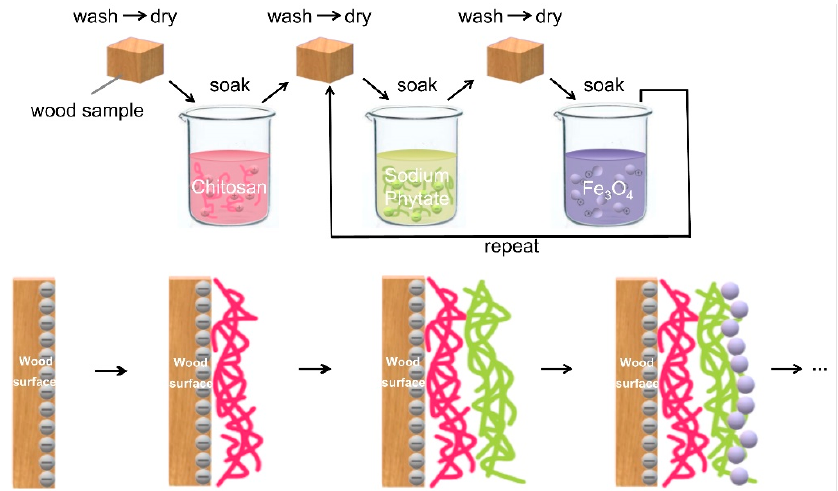
Figure 1. Scheme of fabricating magnetic coating on wood surface by layer-by-layer self- assembly.